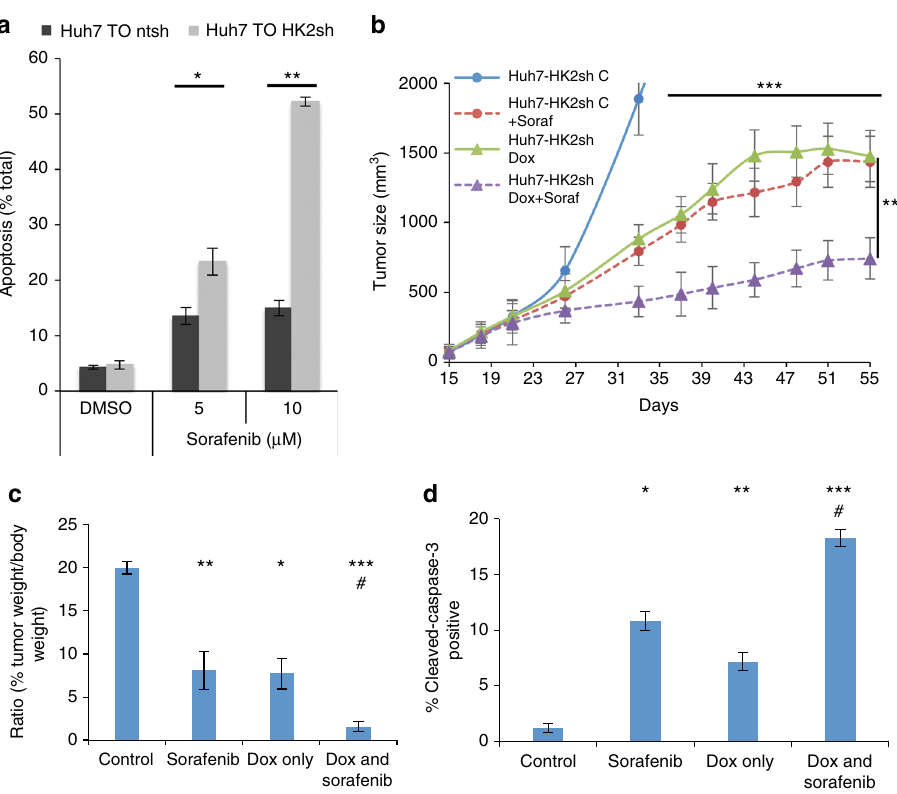
Fig. 8 Effect of HK2 KD and sorafenib on cell death and tumor growth. a The effect of HK2 KD in combination with sorafenib on cell death of Huh7 cells. b Tumor growth in vivo of Huh7 cells expressing Dox-inducible HK2 shRNA in the absence or presence of a Dox-infused diet and in the presence or absence of sorafenib treatment. Note that monitoring the growth of tumors in control mice was stopped because once humane end-point criterion was reached the mice were killed. c Ratio of tumor to body weight at the end-point for control mice and at the last time point for treated mice. d Quanti fi cation of cleaved caspase 3 in the tumor sections. Results represent mean ± SEM, signi fi cance marked by * is to no Dox control and # to Dox control, */ # p < 0.05, ** p < 0.01, *** p < 0.001 by Student ’ s t